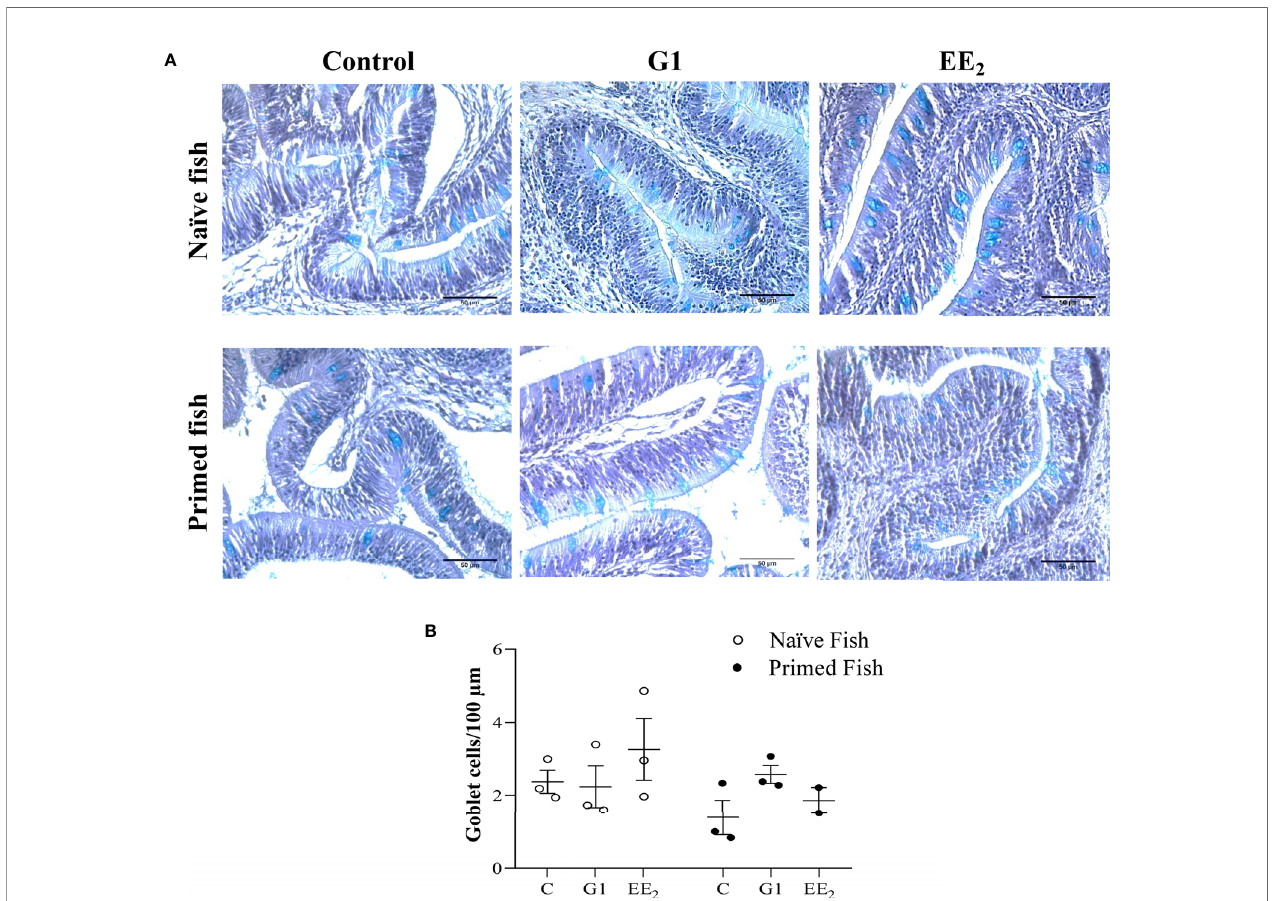
FIGURE 6 | Oral exposure of G1, EE2 and immune priming induce structural changes along the hindgut of gilthead seabream. The fi sh had been orally treated with G1 or EE2 (5 m g/g food) for 43 days and either immune primed with KLH or not (naive) on the previous day. (A) Representative histomorphology image of PAS-A- stained hindgut longitudinal sections with neutral and acid staining goblet cells highlighted in light blue. Besides, note the high number of IEC in fi ltrates present in the lamina propria on both G1 and EE2 conditions. (n = 6; Scale bar = 50 m m). (B) Representative average histological quanti fi cation of the mean number of PAS-positive goblet cells on three randomly selected slides per treatment and condition in